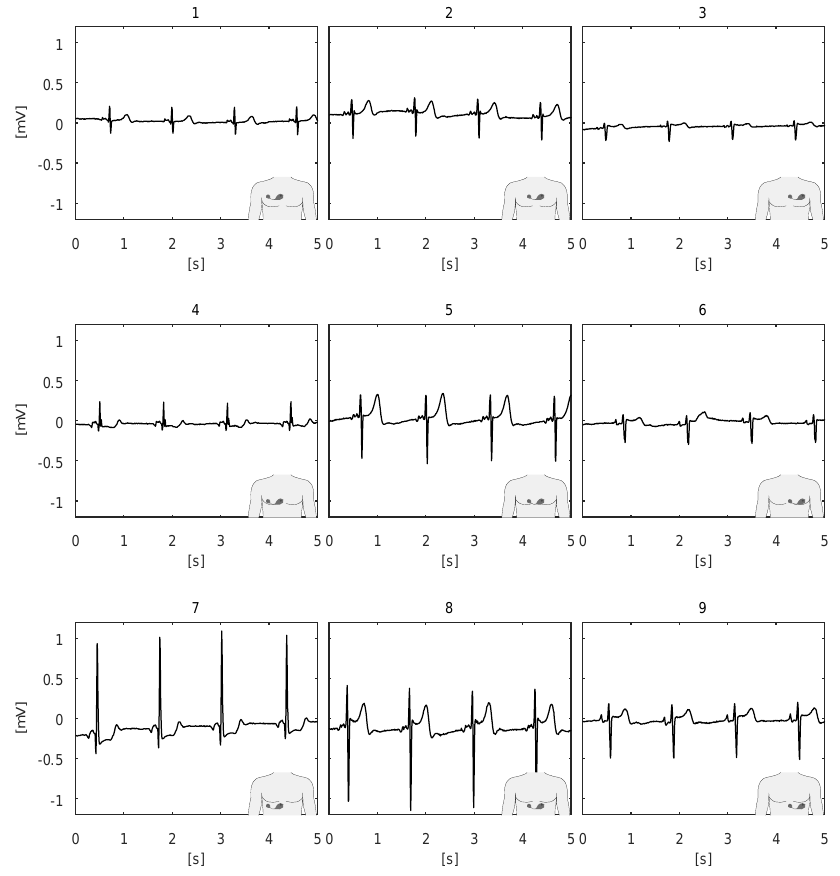
Figure 7. Raw ECG signals recorded from the ECG sensor in positions 1 to 9, obtained by translating the sensor from the horizontal position shown in Figure 6.